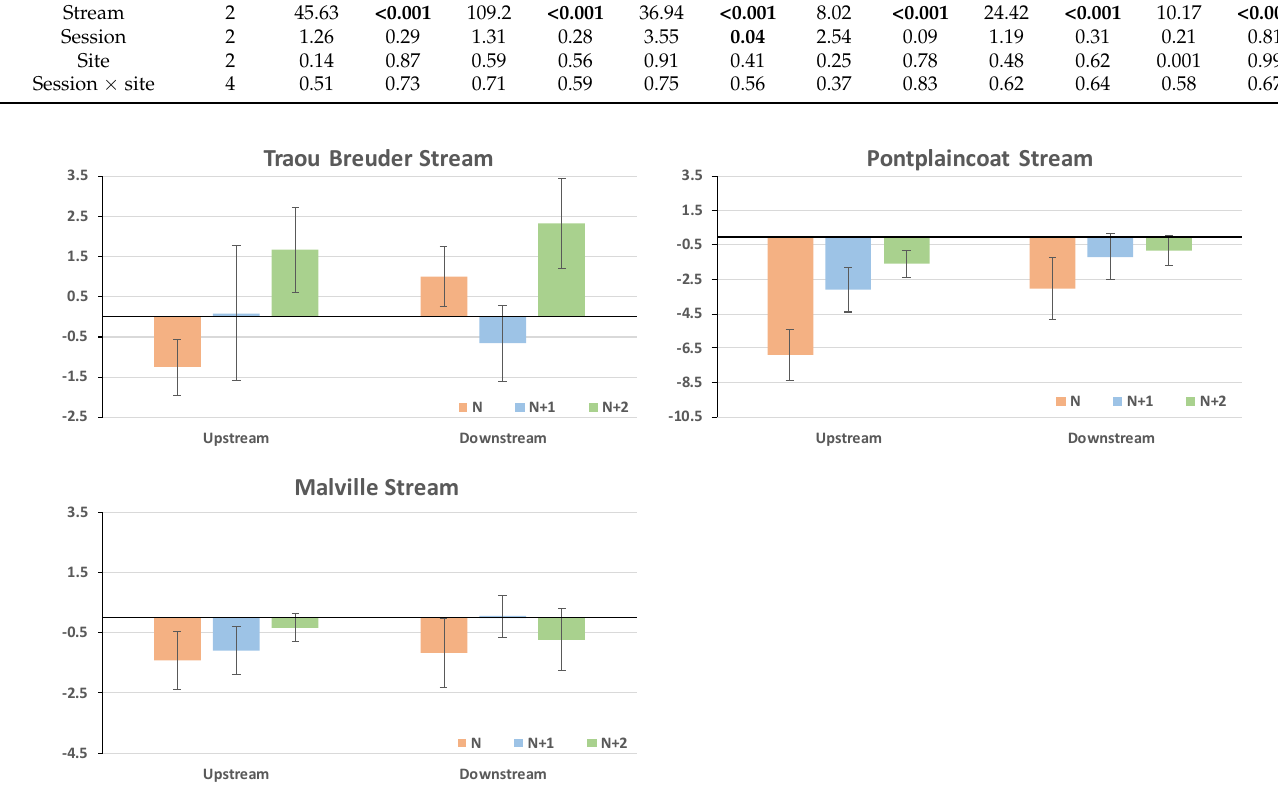
Figure 4. Annual mean deviation ( ± SE) from the mean taxonomic richness in the “control” sites before and after restoration (N: before restoration; N + 1: first year of monitoring after restoration; N + 2: second year of monitoring after restoration).